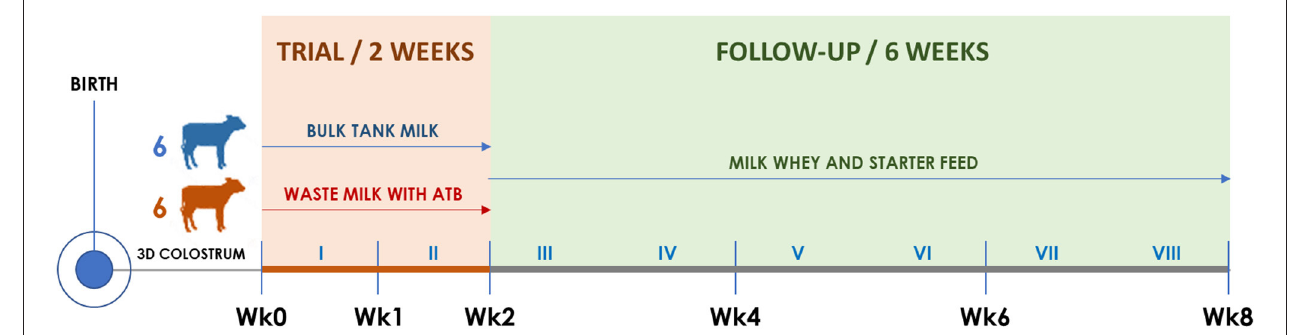
FIGURE 1 | Timeline of the trial illustrating calf groups, diets, and sampling times. Roman numerals indicate weeks. The timing of clinical visits and rectal swab collection is shown according to the trial week, as follows. Wk0: third day of life; Wk1: 10th day of life; Wk2: 17th day of life; Wk4: 31st day of life; Wk6: 45th day of life; Wk8: 59th day of